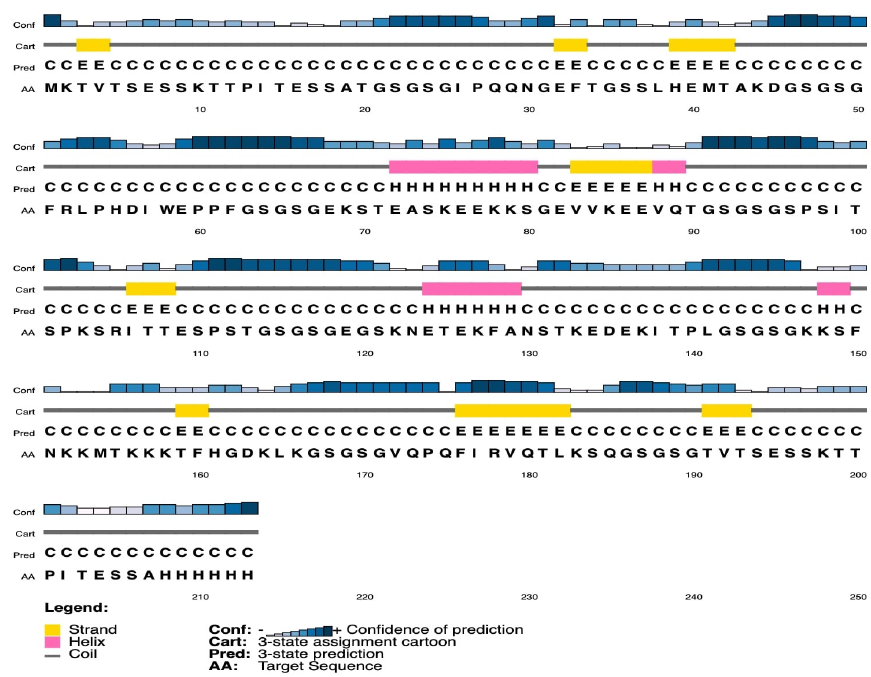
Figure 2. Secondary structure of OvMCBL02 multiepitope antigen predicted using RaptorX server with alpha-helix (8.9%), beta strands (13.1%), and coils (78.0%).